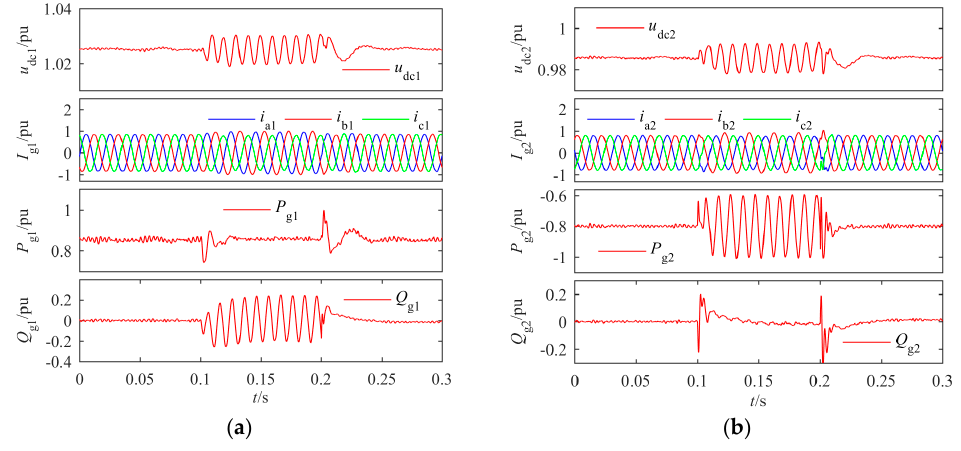
Figure 8. Responses of CS1 ( a ) and CS2 ( b ) to the SOC for OBJ 1 and OBJ 2 respectively.